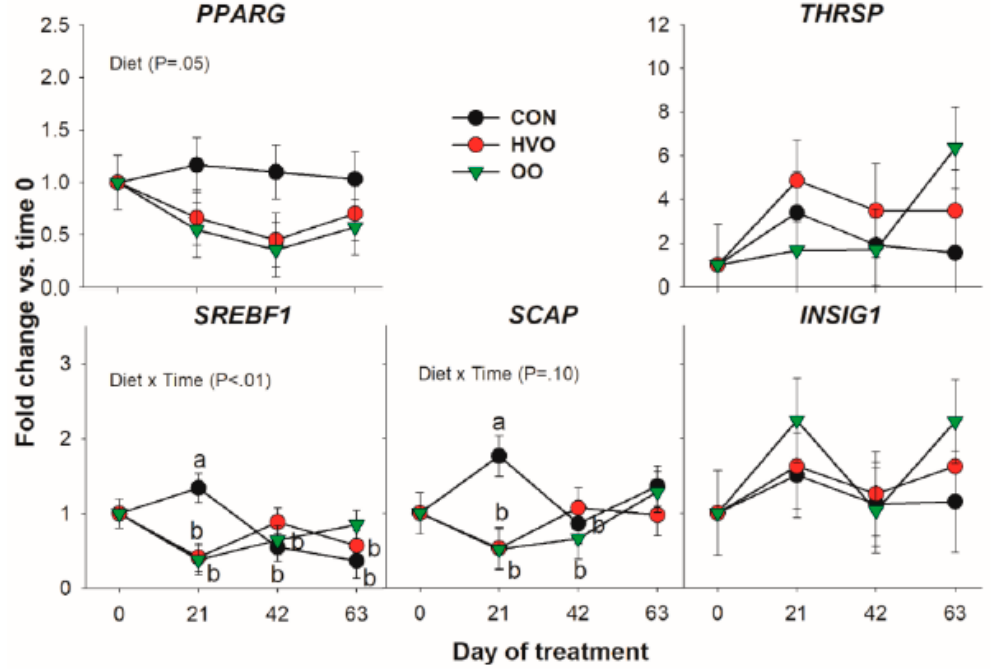
Figure 4. Effect of olive oil (OO) or hydrogenated olive oil (HVO) on transcripts coding for proteins involved in transcription regulation of lipid-related genes. Reported in the graph are the P-value of the overall effect of Diet and Diet×Time. Diverse letters denote significant post-hoc differences ( p < 0.05).